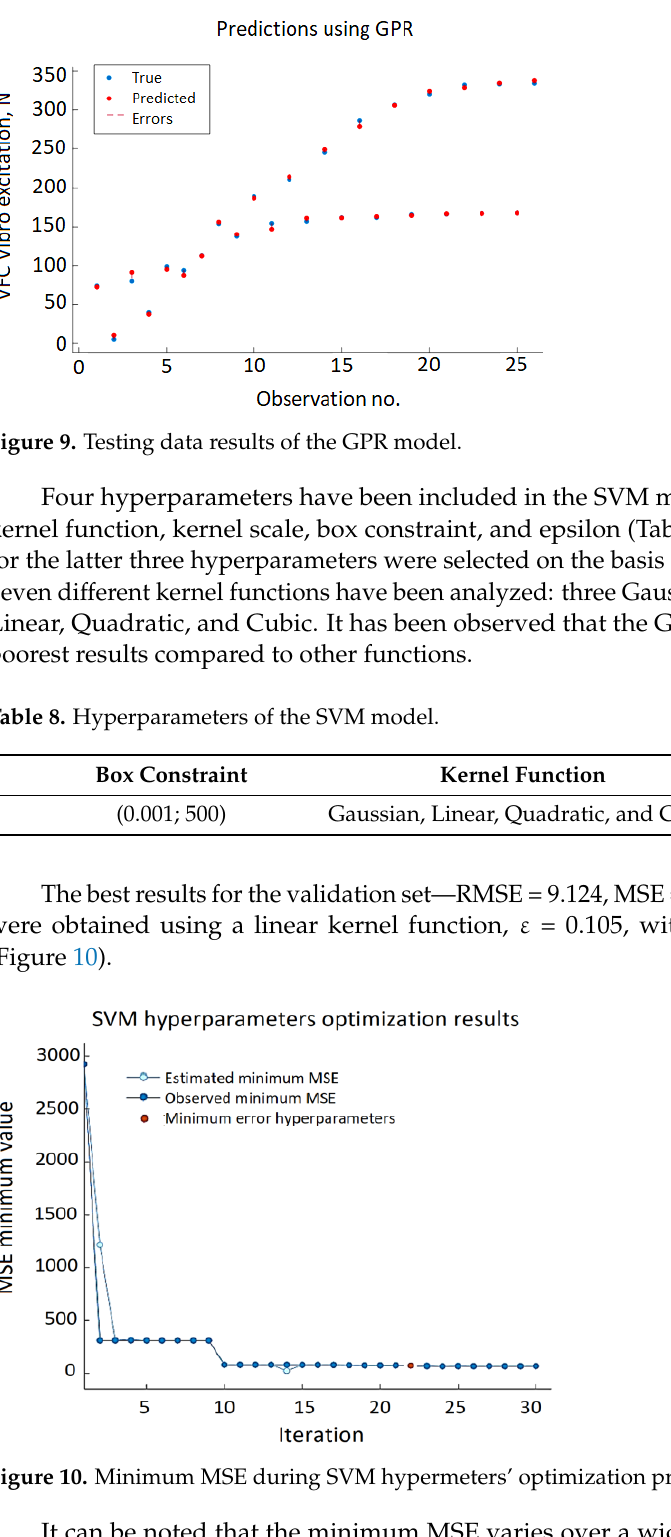
Figure 8. Minimum MSE during GPR hypermeters’ optimization process.